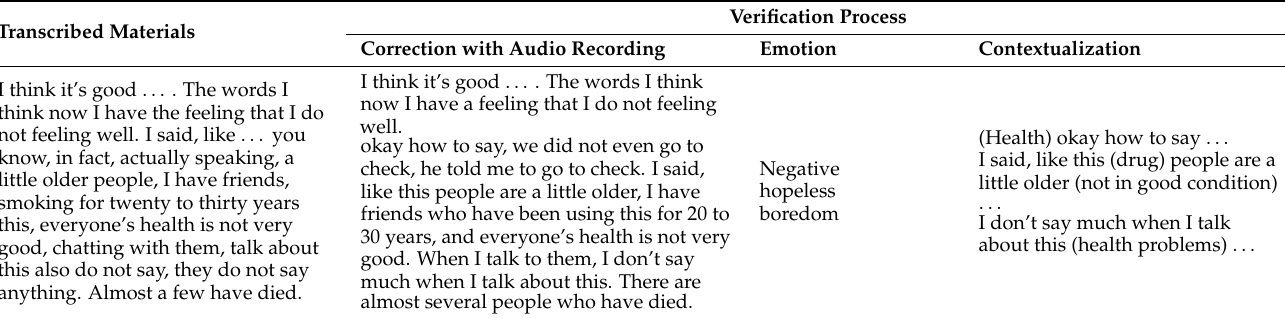
Table A1. Translation and verification (fragments).